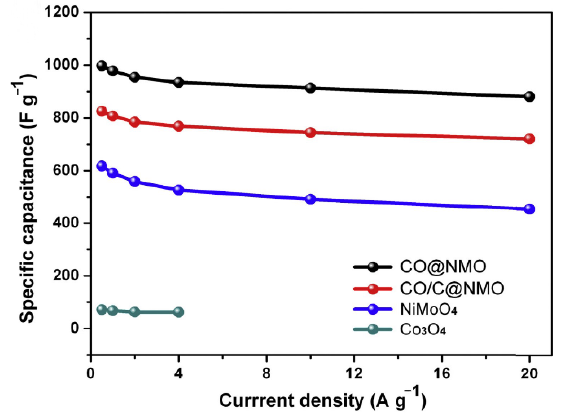
Figure 17. Specific capacitance of CO@NMO, CO/C@NMO, NiMoO 4 andCo 3 O 4 electrodes. Repro- duced with permission from Ping Yang, Synthesis of hierarchical tube-like yolk-shell Co 3 O 4 @NiMoO 4 for enhanced supercapacitor performance; published by Elsevier, 2018 [180] .